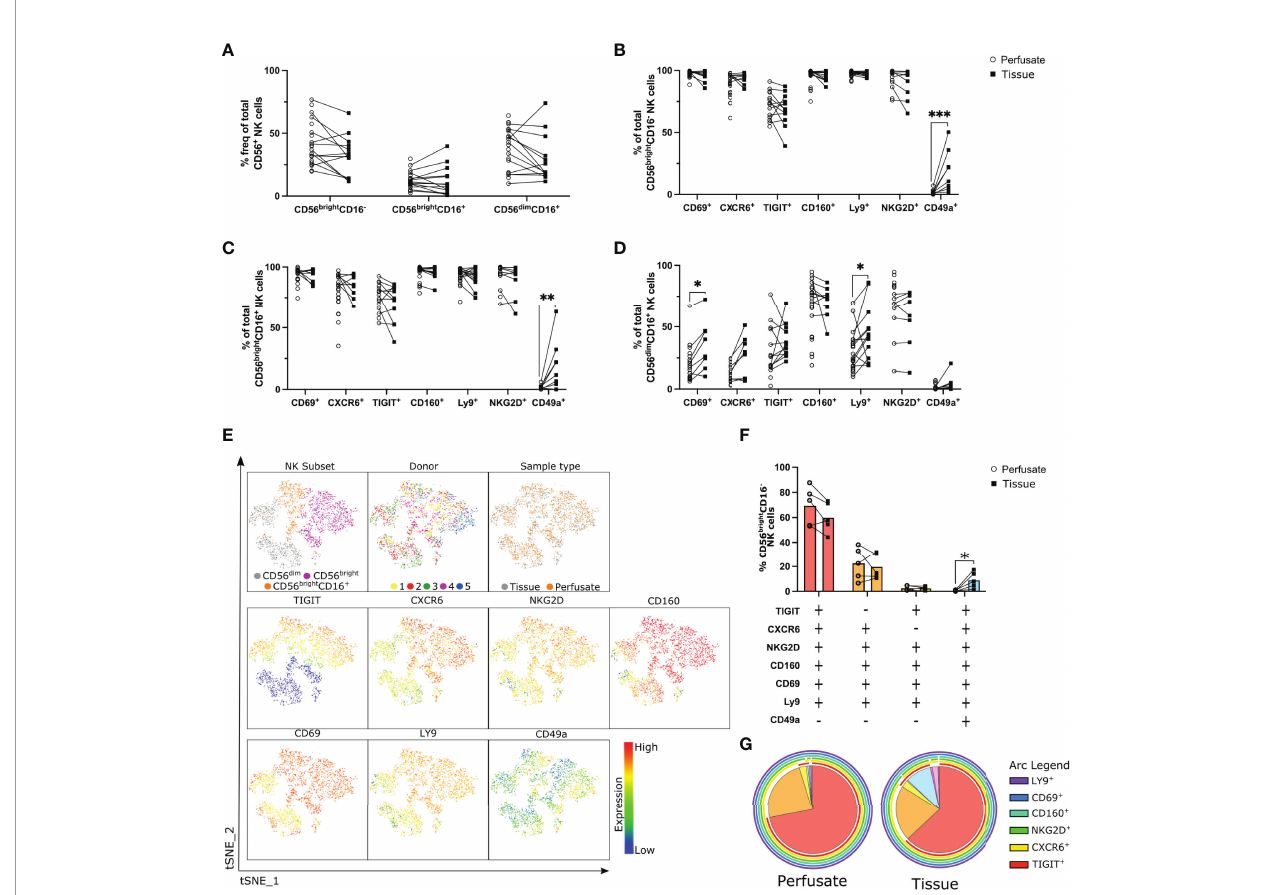
FIGURE 2 | Co-expression of CD69, CXCR6, TIGIT, CD160, Ly9 and NKG2D de fi nes a liver-resident CD56 bright NK cell subset. Flow cytometry analysis liver- residency associated markers on NK cell subsets in liver perfusate and tissue samples (n = 5-25). (A) , Frequency of NK cell subsets in liver perfusate and tissue samples (n = 5-25, matched samples indicated with a line). (B, D) , Percent frequency of CD69 + , CXCR6 + , TIGIT + , CD160 + , Ly9 + , NKG2D + , and CD49a + CD56 bright CD16 - (B) , CD56 bright CD16 + (C) , and CD56 dim CD16 - (D) NK cells in perfusate and tissue samples. (E) , tSNE analysis of NK cells from 5 matched liver perfusate and tissue samples visualising CD56 bright (CD16 - ), CD56 bright CD16 + , and CD56 dim (CD16 + ) NK cell subsets ’ distinct cell surface receptor expression patterns. (F, G) , SPICE analysis visualising co-expression of cell surface receptors on CD56 bright CD16 - NK cells in matched liver perfusate and tissue samples represented as a scatter plot (F) and a pie chart (G) . Data analysed using an unpaired Mann-Whitney test (B – D) or a paired t test (F) . * p< 0.05, **p < 0.01, ***p <